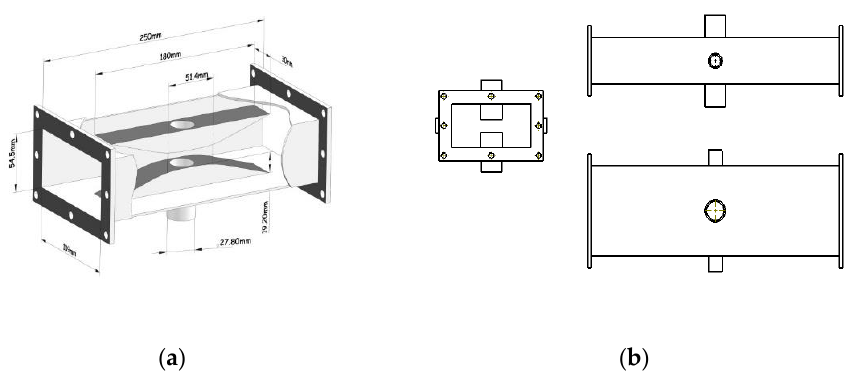
Figure 1. Schematic of ridge waveguide: ( a ) 3-D structure; ( b ) Three views.